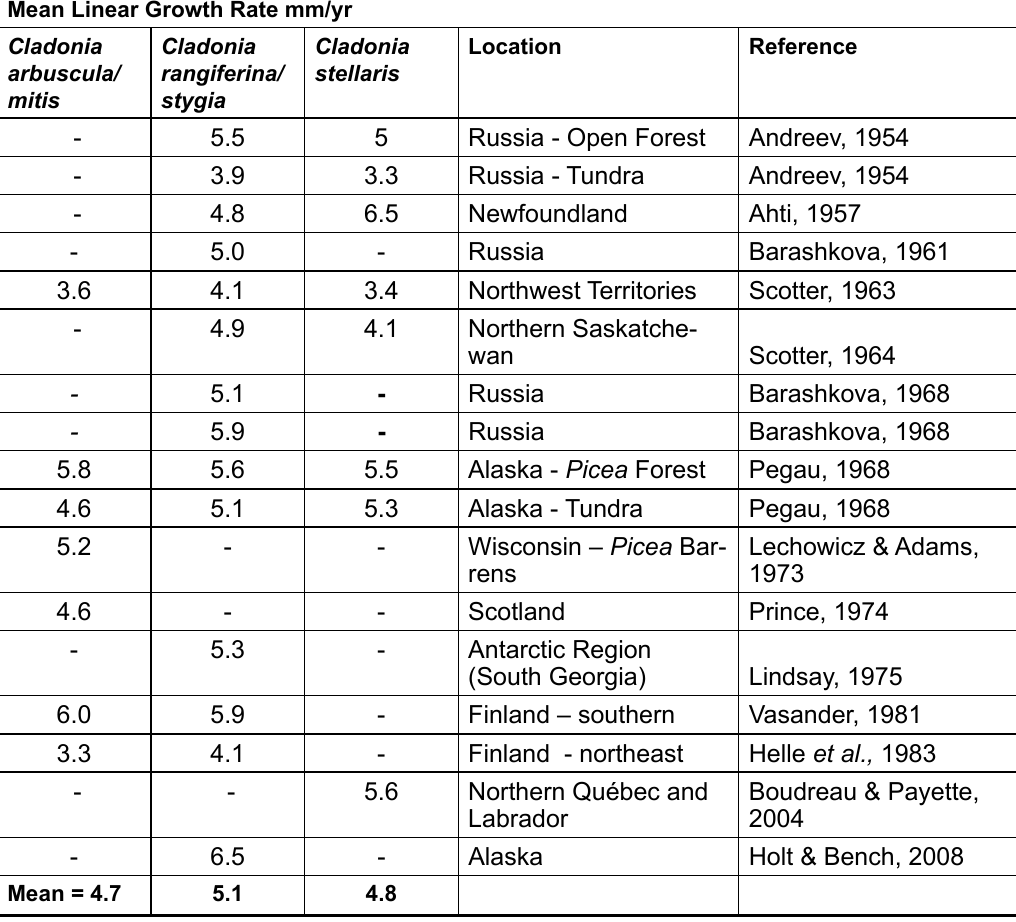
Table 1. Mean annual growth rates (mm/yr) of Cladonia arbuscula/mitis ., C. rangiferina/stygia , and C. stellaris